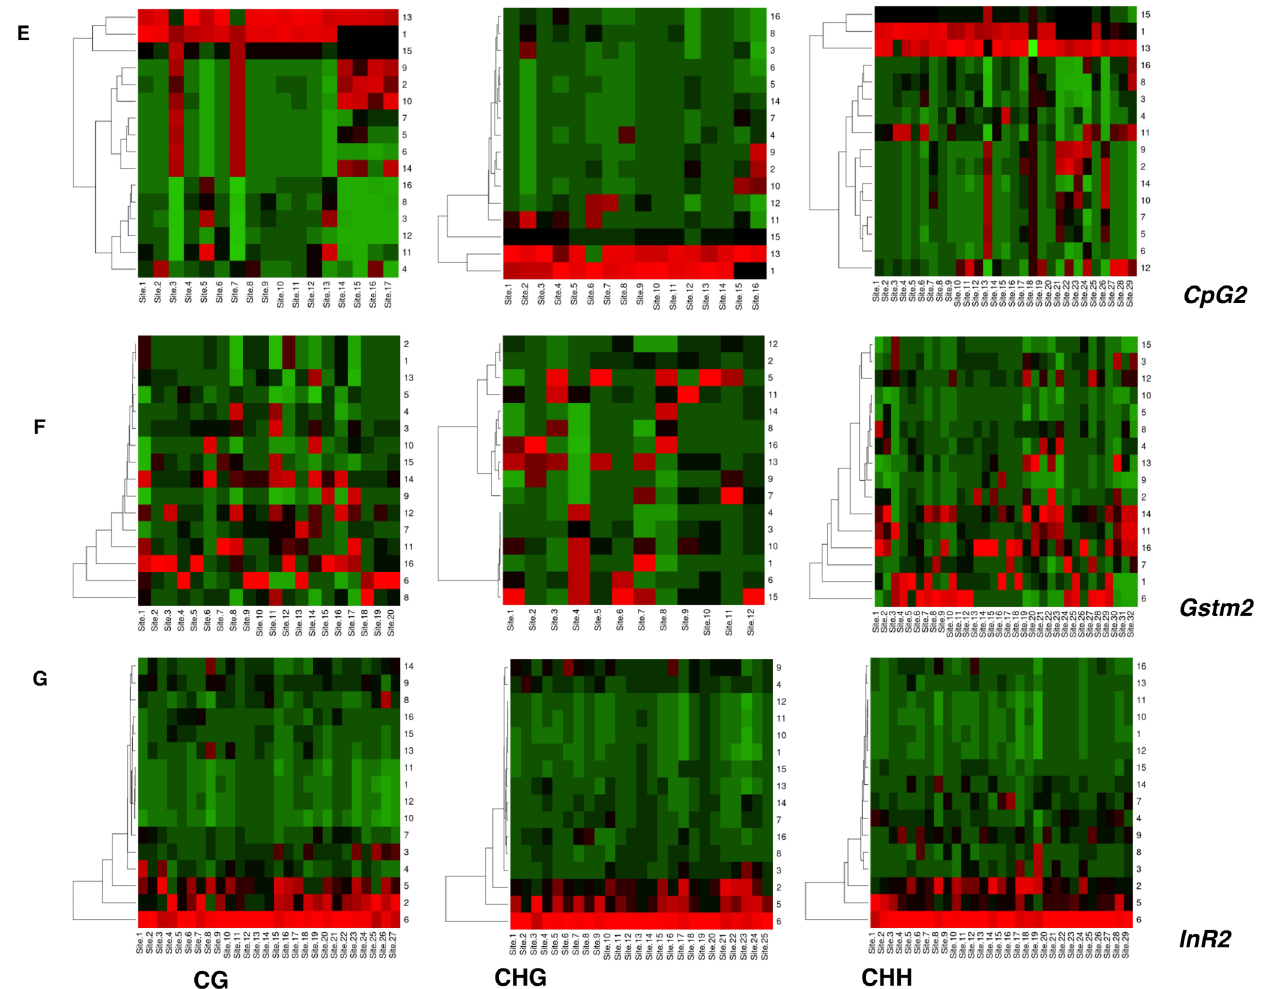
Figure 8. Site-specific analysis of the heritability of stress-induced methylation marks in BPH. Heatmaps were plotted for the cytosine sites (within CpG islands corresponding to stress-responsive genes; A – G ) that exhibited significant variation between samples, in all three contexts. Gene names are mentioned at the right, and context information is provided at the bottom. Numbers on the right of each plot correspond to sample names, which are as follows: 1. BOD_AD 2. BOD_NY 3. PR 4. RG1 5. RG4 6. RNG1 7. RNG4 8. PI 9. IG1 10. IG4 11. ING1 12. ING4 13. RT1 14. RT2 15. IR1 16. IR2. The colour scale represents an increase in methylation from red to green.